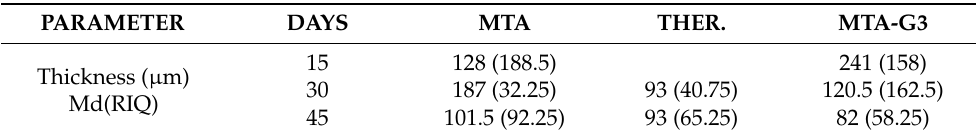
Table 9. MTA, Theracal and MTA-G3 fibrous capsule thickness. Differences between materials according to